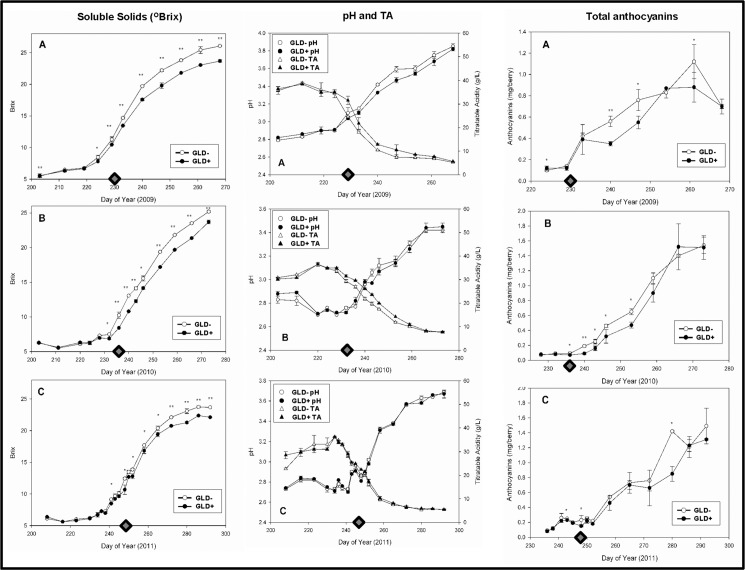
Impacts of grapevine leafroll disease (GLD) on fruit quality.Time-course analyses of impacts of GLD on fruit maturity indices (total soluble solids, pH, titratable acidity and total anthocyanins) in own-rooted wine grape cv. Merlot during (A) 2009, (B) 2010 and (C) 2011 seasons. Line drawings with open circles represent samples from non-symptomatic (healthy) vines while line drawings with colored circles represent samples from symptomatic (infected) vines. Each data point represents means of five replicates per treatment. Approximate date of véraison in each season is denoted by the grey diamond. Statistical significance was determined by one-way ANOVA: (* = p ≤ 0.05; ** = p ≤ 0.001).